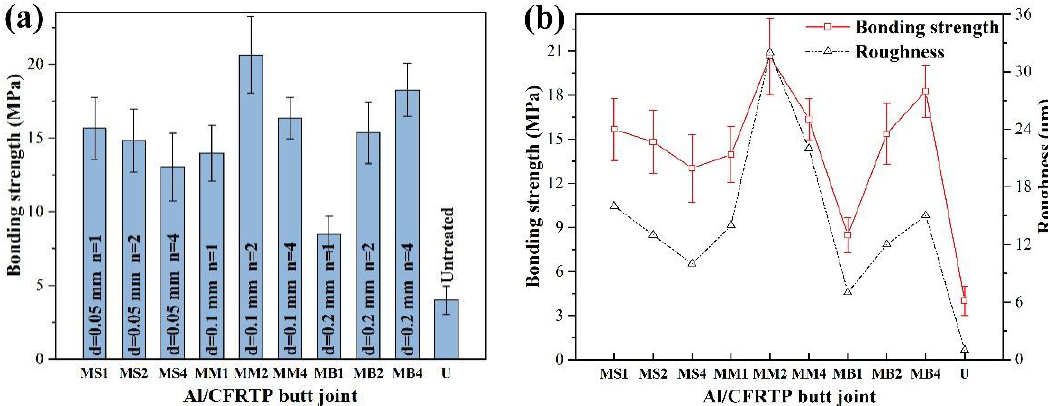
Figure 6. ( a ) Bonding strength of the Al/CFRTP butt joint with different laser micro-texturing Al joining interface and ( b ) variation of surface roughness and bonding strength of Al alloy pretreated by different laser micro-textures.